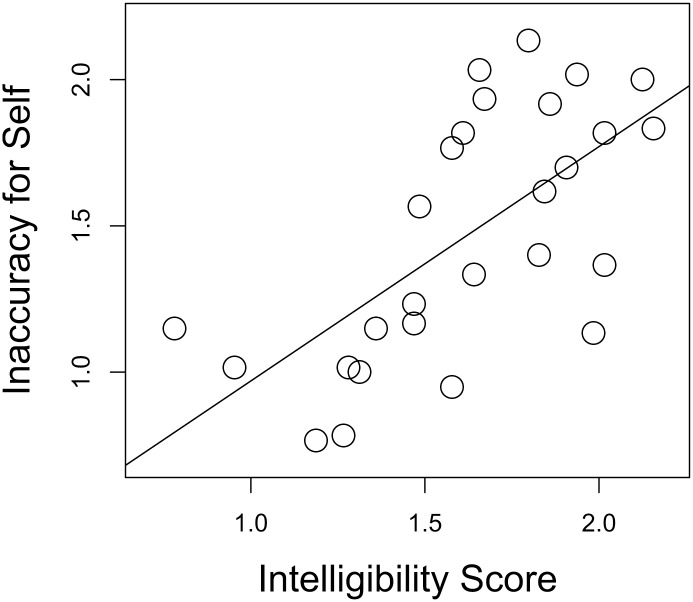
Intelligibility ratings by Levenshtein Distance for each speaker (Experiment 2) plotted against that speaker’s inaccuracy for Self-produced stimuli (Experiment 1), with regression line.